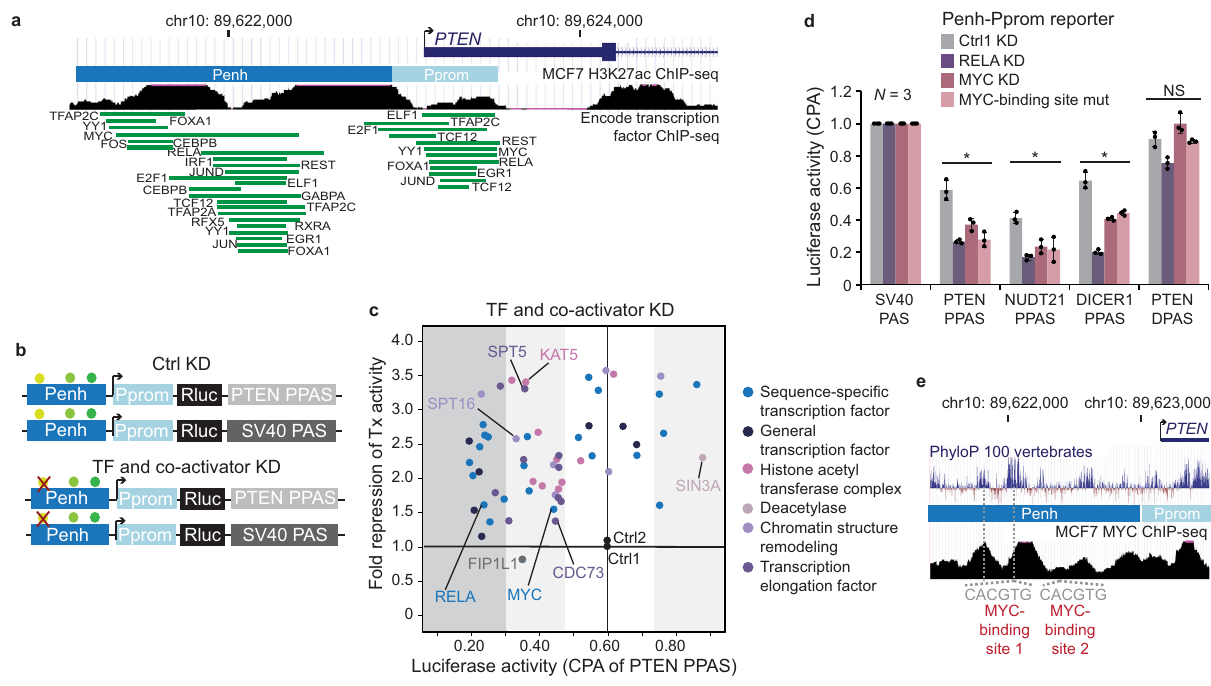
Fig. 4 Transcription and transcription elongation factors are widespread regulators of CPA activity. a As in Fig. 1a but shown are the binding sites of transcription factors that were knocked-down individually. b Schematic of reporter constructs to identify transcription factors (TFs) and co-activators that regulate CPA activity in the context of the Penh-Pprom reporter. Ctrl KD, control knock-down. c Summary of PTEN PPAS CPA activity and fold repression of Tx activity obtained in the shRNA screen. Shown is the mean in ctrl KD and transcription factor KD samples for the Penh-Pprom reporter. The values are reported in Table 1 and the replicates are shown in Supplementary Fig. 4a, b. The shaded areas denote the extent of change in CPA activity in TF KD samples (white, change is not signi fi cant; gray, signi fi cant change; dark gray, more than 0.30 change in CPA activity). d CPA activity of additional PAS when transcribed from the Penh-Pprom reporter. Shown is mean ± std of n = 3 biologically independent experiments after transcription factor KD or mutation of MYC-binding sites (MYC-binding site mut) in the Penh. Two-tailed t -test for independent samples was performed; * P < 0.03; NS